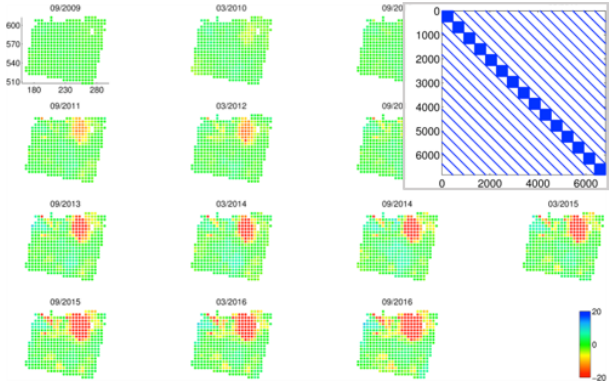
Figure 5. Spatio-temporal variograms computed from RadarSAT-2 InSAR data over the assumed stable area. Table 1. Estimated variogram model parameters.